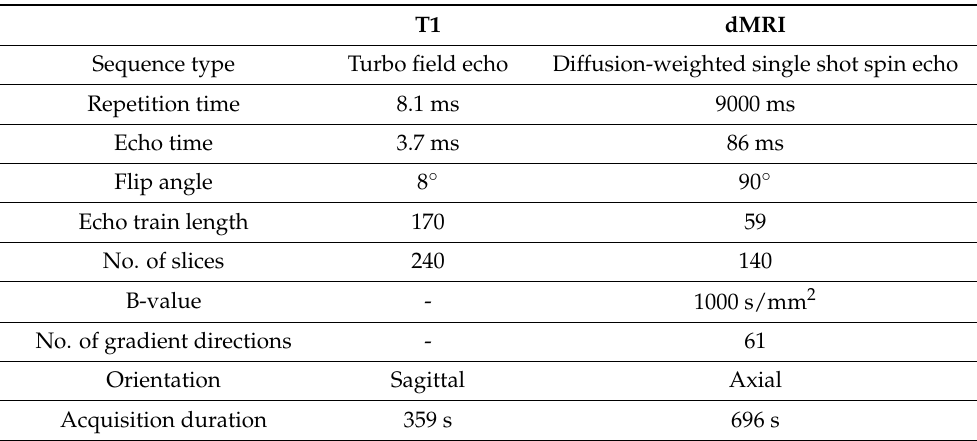
Table 2. Details of the MRI acquisitions employed.